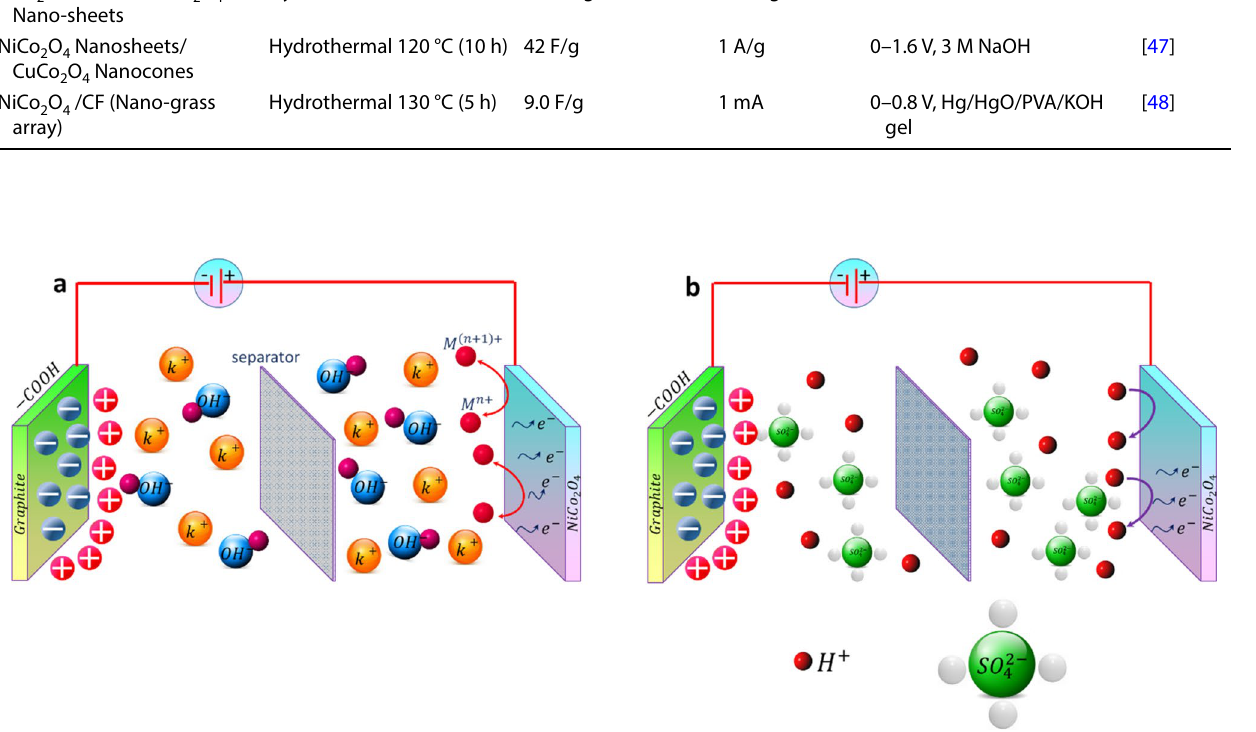
Table 1 Specific capacitance of different structures of NiCo Structure